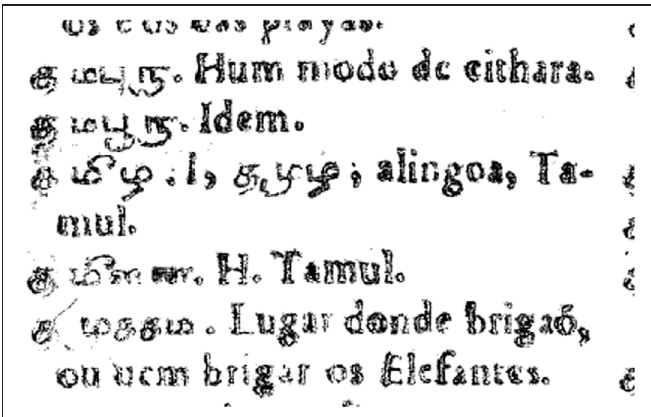
Figure 2: Five entries (342_L_h to 342_L_l) from the 1679 VTCSP (Vocabulario Tamulico Com a Significaçam